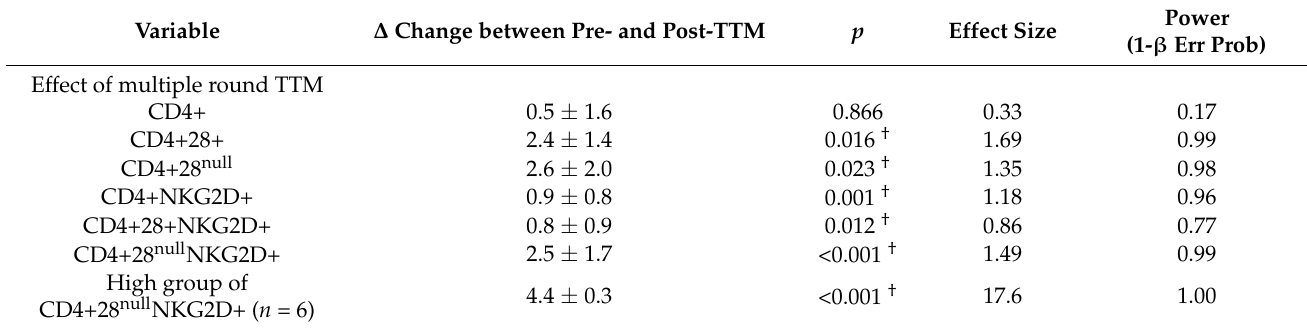
Table 3. Effect sizes and post hoc power